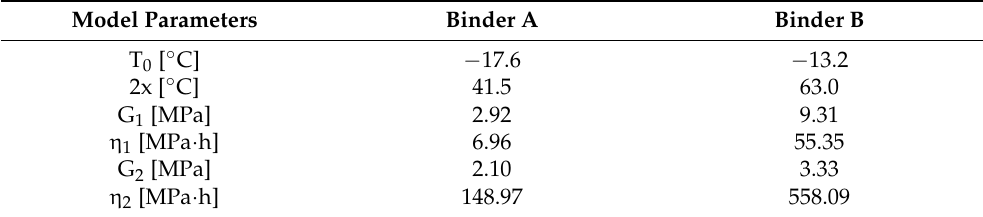
Figure 11. HR of binder B: ( a ) comparison between modeled and experimental data, ( b ) goodness of fit of the improved model. Table 4. Improved model